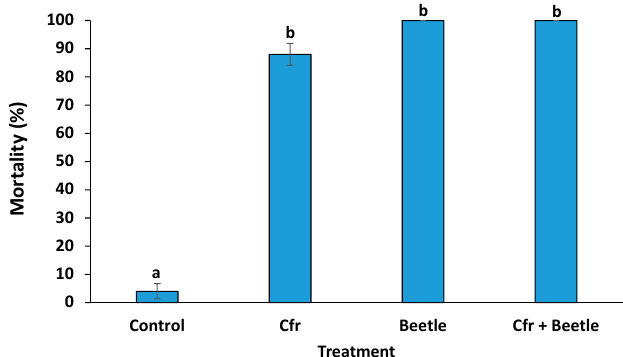
Figure 2. Mean mortality ( ± SEM) of Aleurothrixus trachoides nymphs after Red Missile ornamental pepper plant leaves were sprayed with: water only (control), and allowed to air dry; Cordyceps fumosorosea (Cfr) only; water only, and then one adult Delphastus catalinae (beetle) was released; and C. fumosorosea, and then one adult D. catalinae beetle was released (Cfr + beetle). Letters above the bars (± SEM) that are the same are not significantly different (Fisher’s LSD test, p < 0.05).